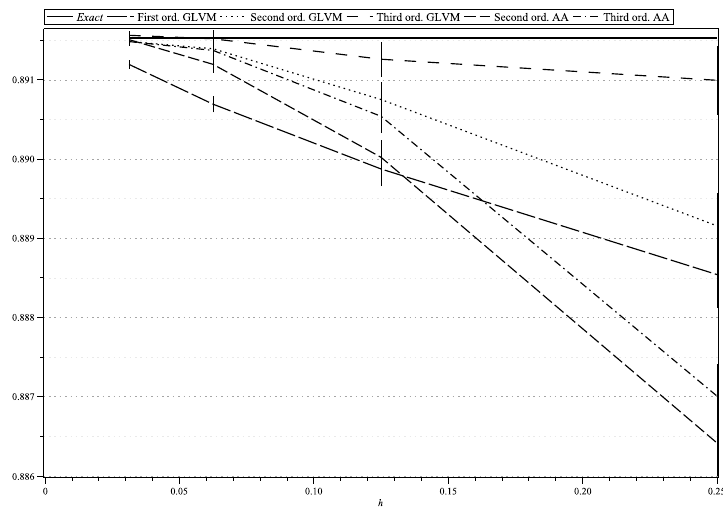
Figure 2. E e − ( 1/2 ˆ X x 1 ) as functions of h : σ = 2.0, θ = 0.04, β = 0.1, x 0 =